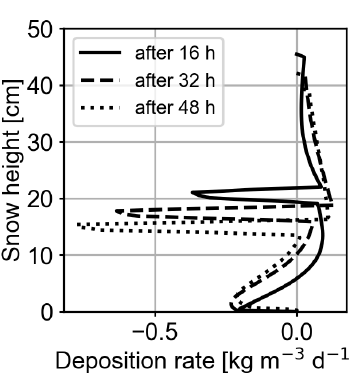
Figure D1. The plot shows the deposition rate profiles for 16, 32 and 48h simulation times for Case 8 (Table 2), which is the fully coupled processes combined with the non-linear version of Glen’s law. The y axis depicts snow